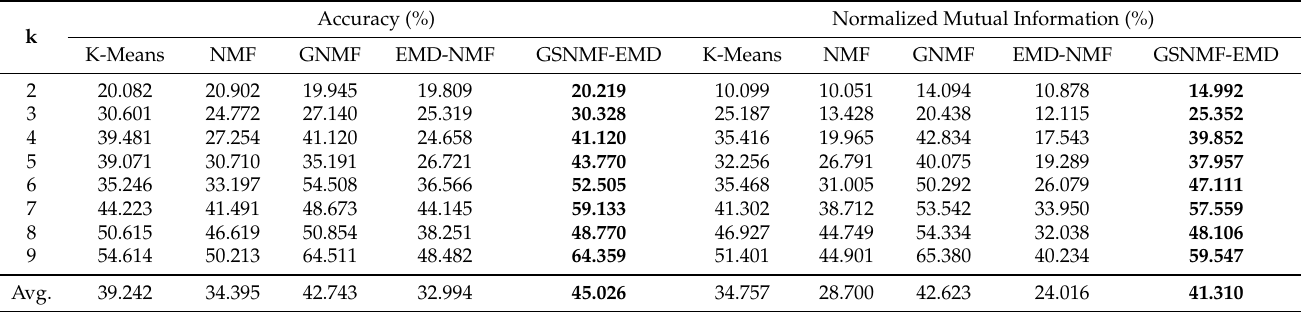
Table 3. Clustering performance on the MNIST